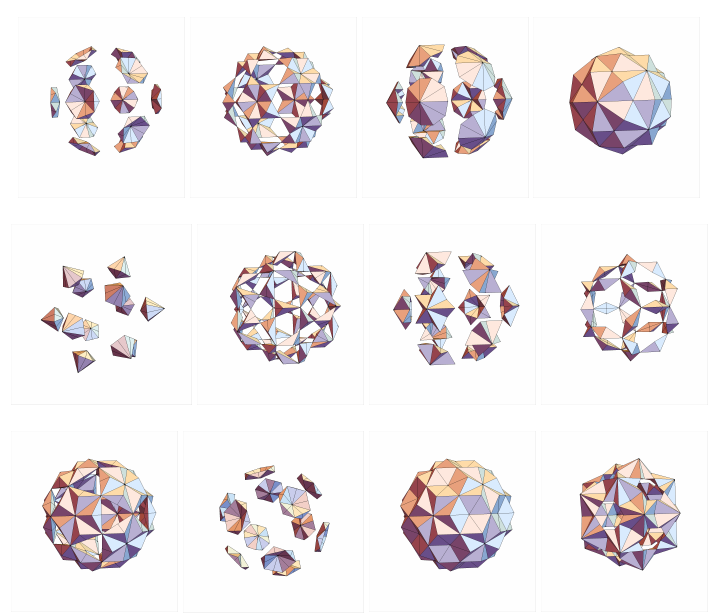
Figure 8. Sectors corresponding to twelve of the 36 vertex types of the tiling T ( D 6 ) (projection D 6 → E 3 ) are shown. Each vertex configuration comes in 120 orientations (respecting the H 3 symmetry present in E (cid:107) ) and so each configuration corresponds to 120 individual sectors in W . Each group of 120 sectors, in turn, exhibits the same H 3 symmetry in the cut-window W ⊂ E ⊥